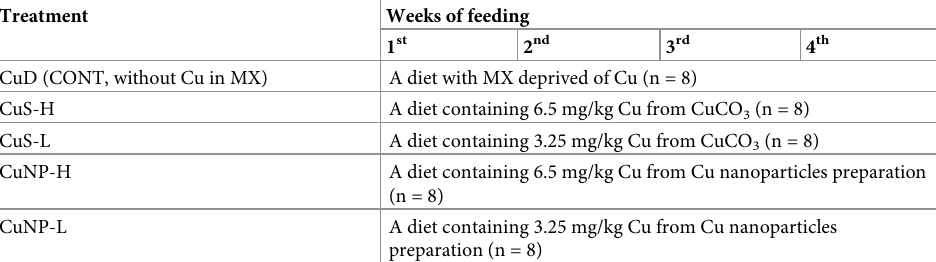
Table 2. Experimental schema a (provided copper dosage was calculated taking into account CuCO 3 in MX or cop- per from Cu nanoparticles preparation). Treatment Weeks of feeding 1 st 2 nd